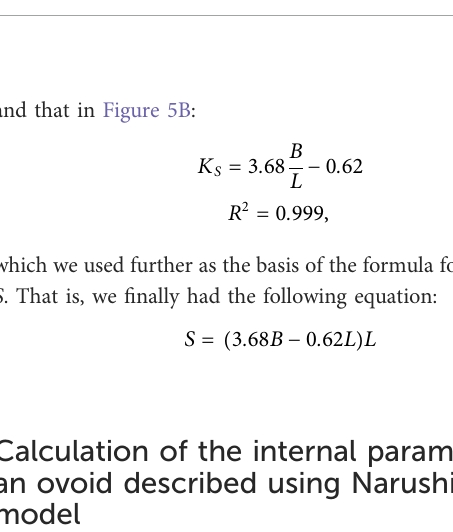
FIGURE 5 Graphical dependence of the function K S = f ( B / L ) for the interval: (A) B / L = [0.48 ... 1]; and (B) B / L = [0.55 ...